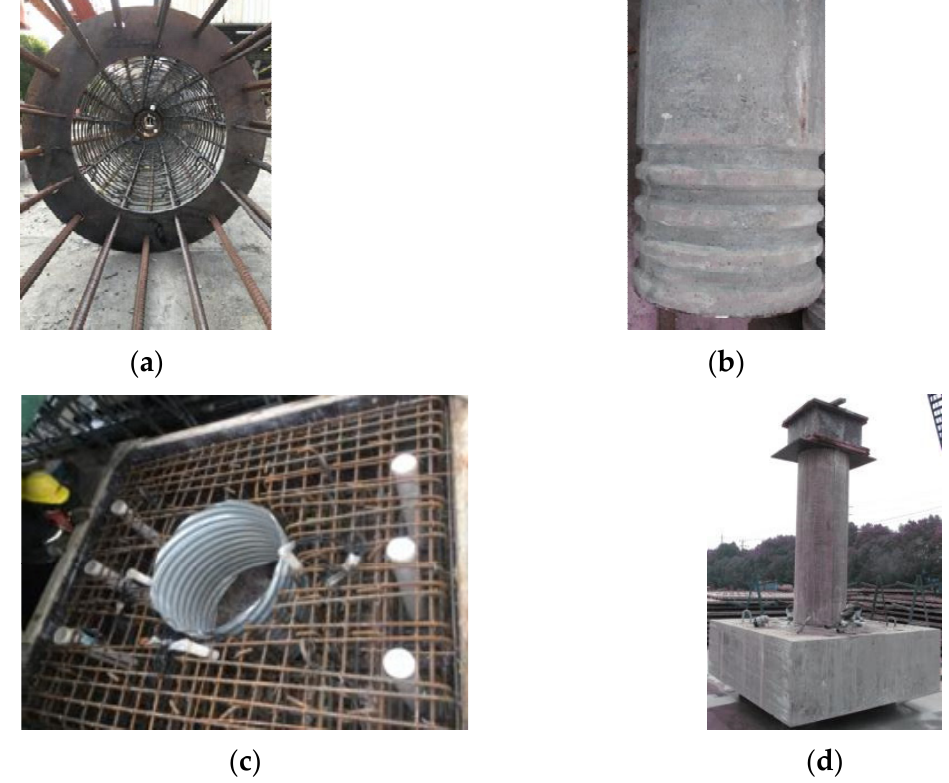
Figure 7. The model construction process. ( a ) Bridge pier reinforcement cage; ( b ) pier shear key; ( c ) cap steel cage; ( d ) model test piece.